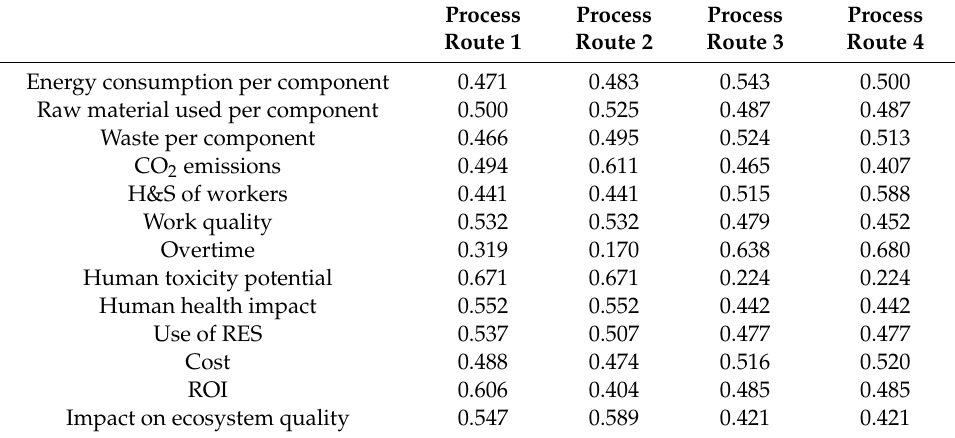
Table 4. Normalized